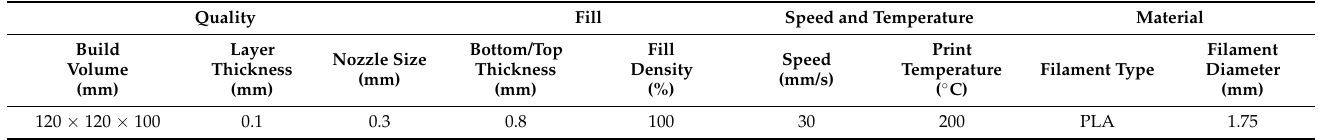
Table 1. Printing parameters of the MEX